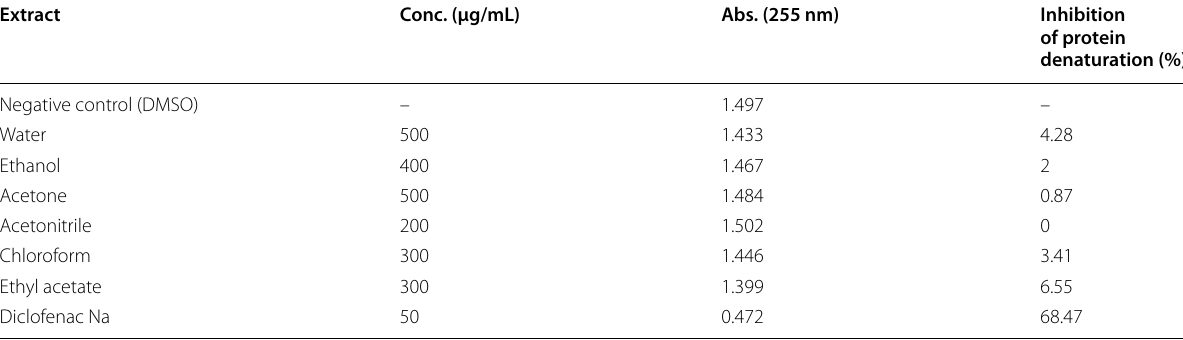
Table 3 Assessment of anti-inflammatory activity of H. erinaceus extracts Extract Conc. (µg/mL)